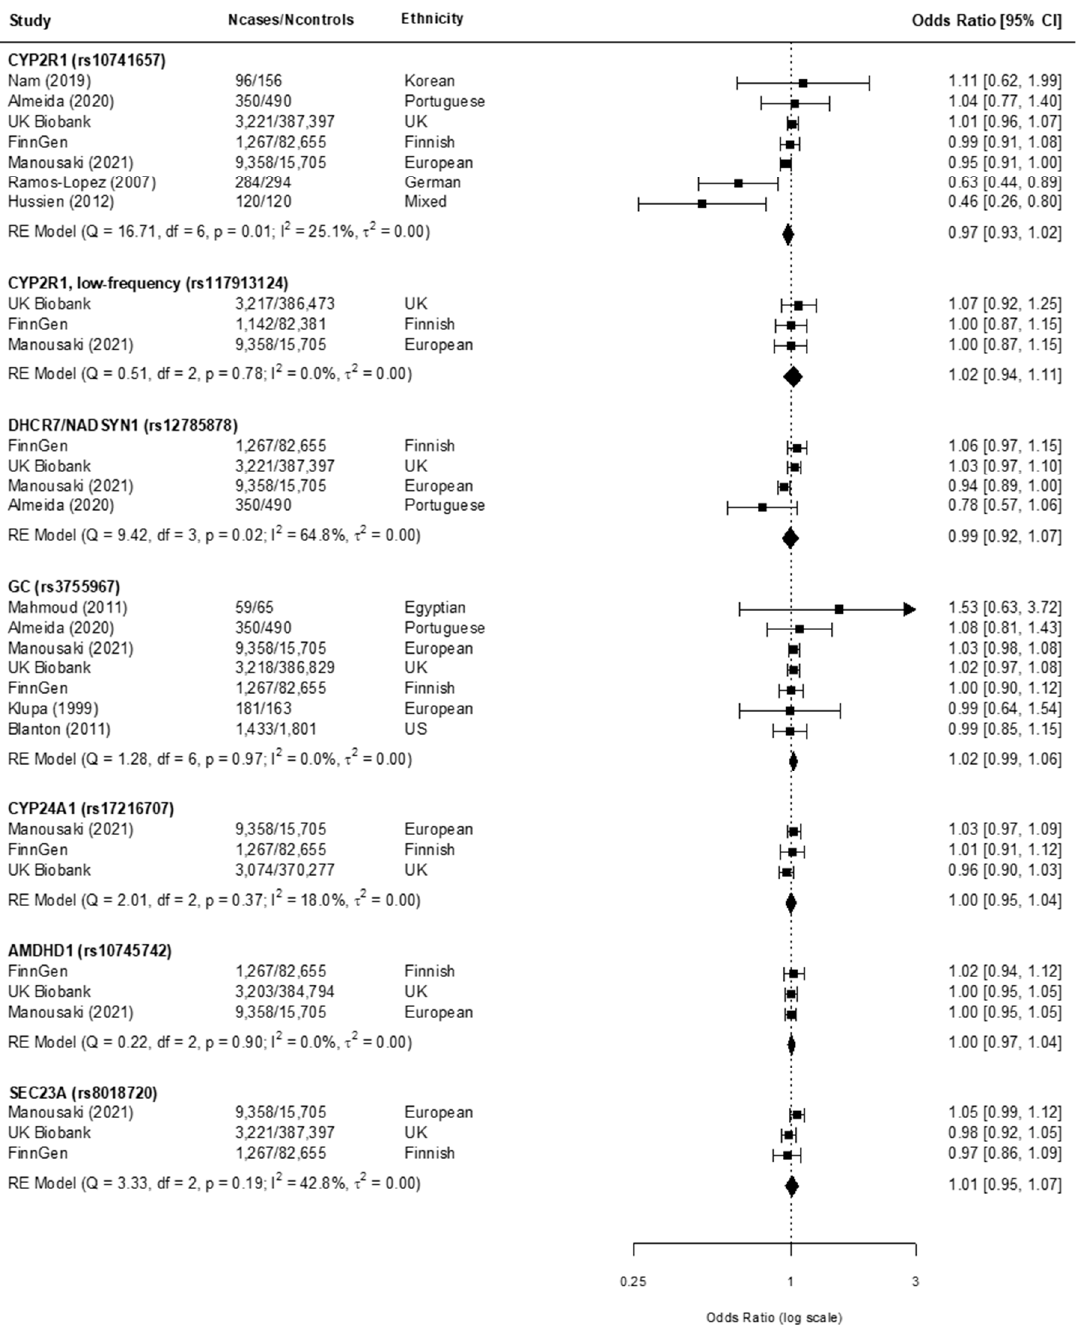
Figure 2. Meta-analysis for the association between selected genetic variants affecting serum 25-hydroxyvitamin concen- trations and type 1 diabetes with the random effects model (variants coded by 25-hydroxyvitamin D increasing alleles). Squares represent the individual odds ratio estimate. Diamonds show the pooled effect. Horizontal bars represent the 95% confidence intervals.